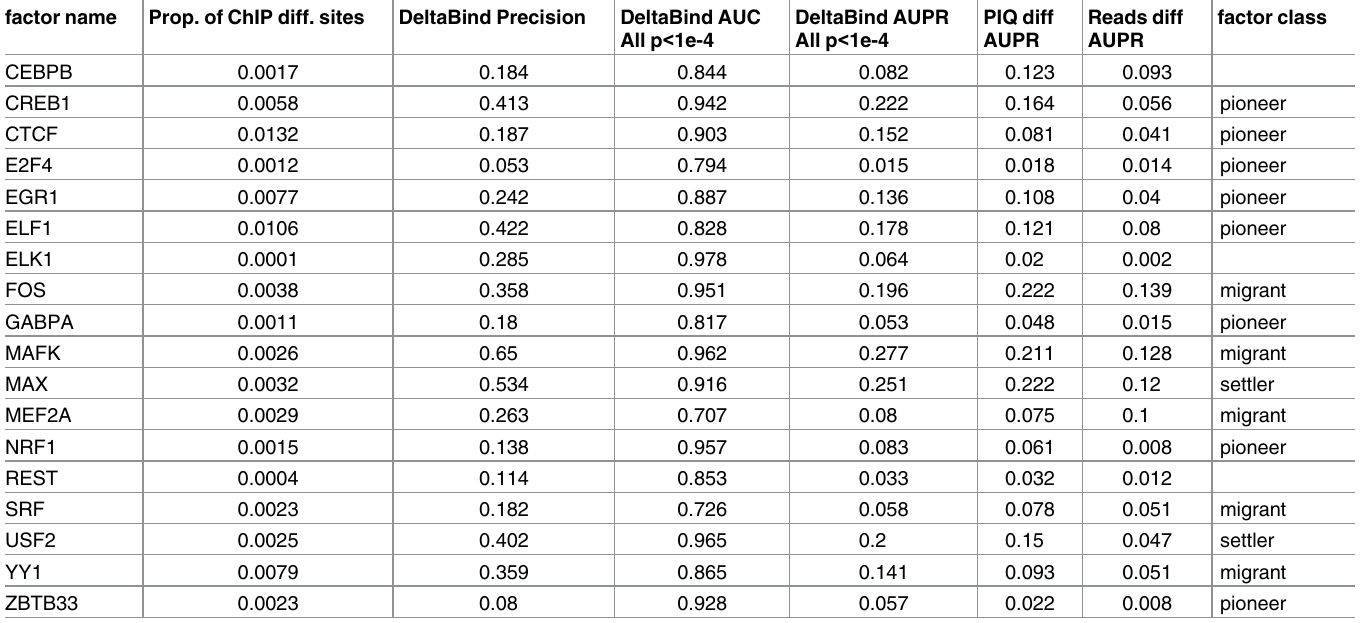
Table 1. Summarystatistics of differential binding prediction for different factors. factor name Prop. of ChIP diff.